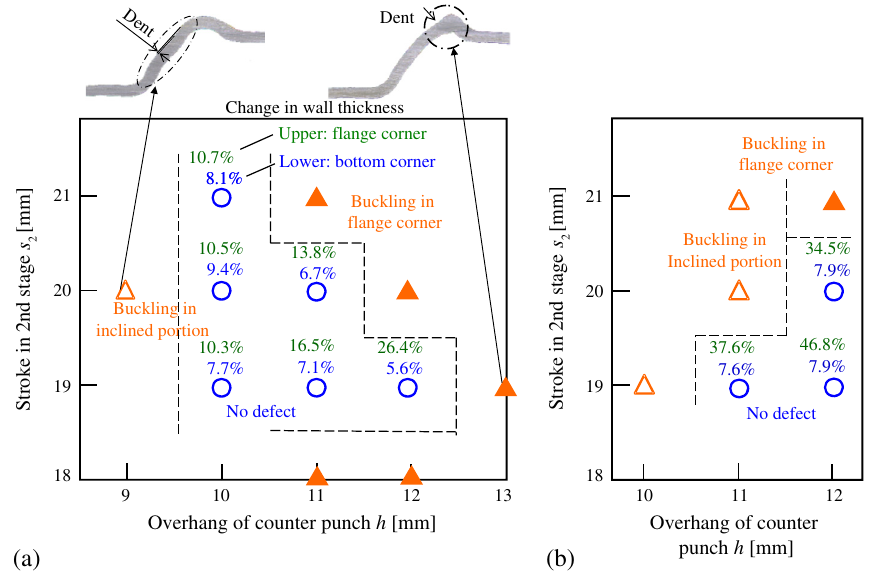
Figure 6. Forming range and changes in wall thickness at flange and bottom corners: (a) s 1 = 23 mm and (b) s 1 = 24 mm.